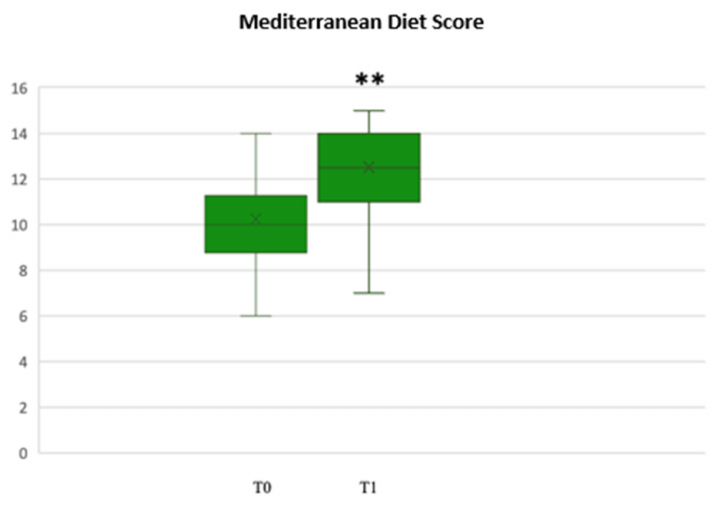
Figure 4. Mediterranean score adherence at T0 and T1. ** p < 0.001.